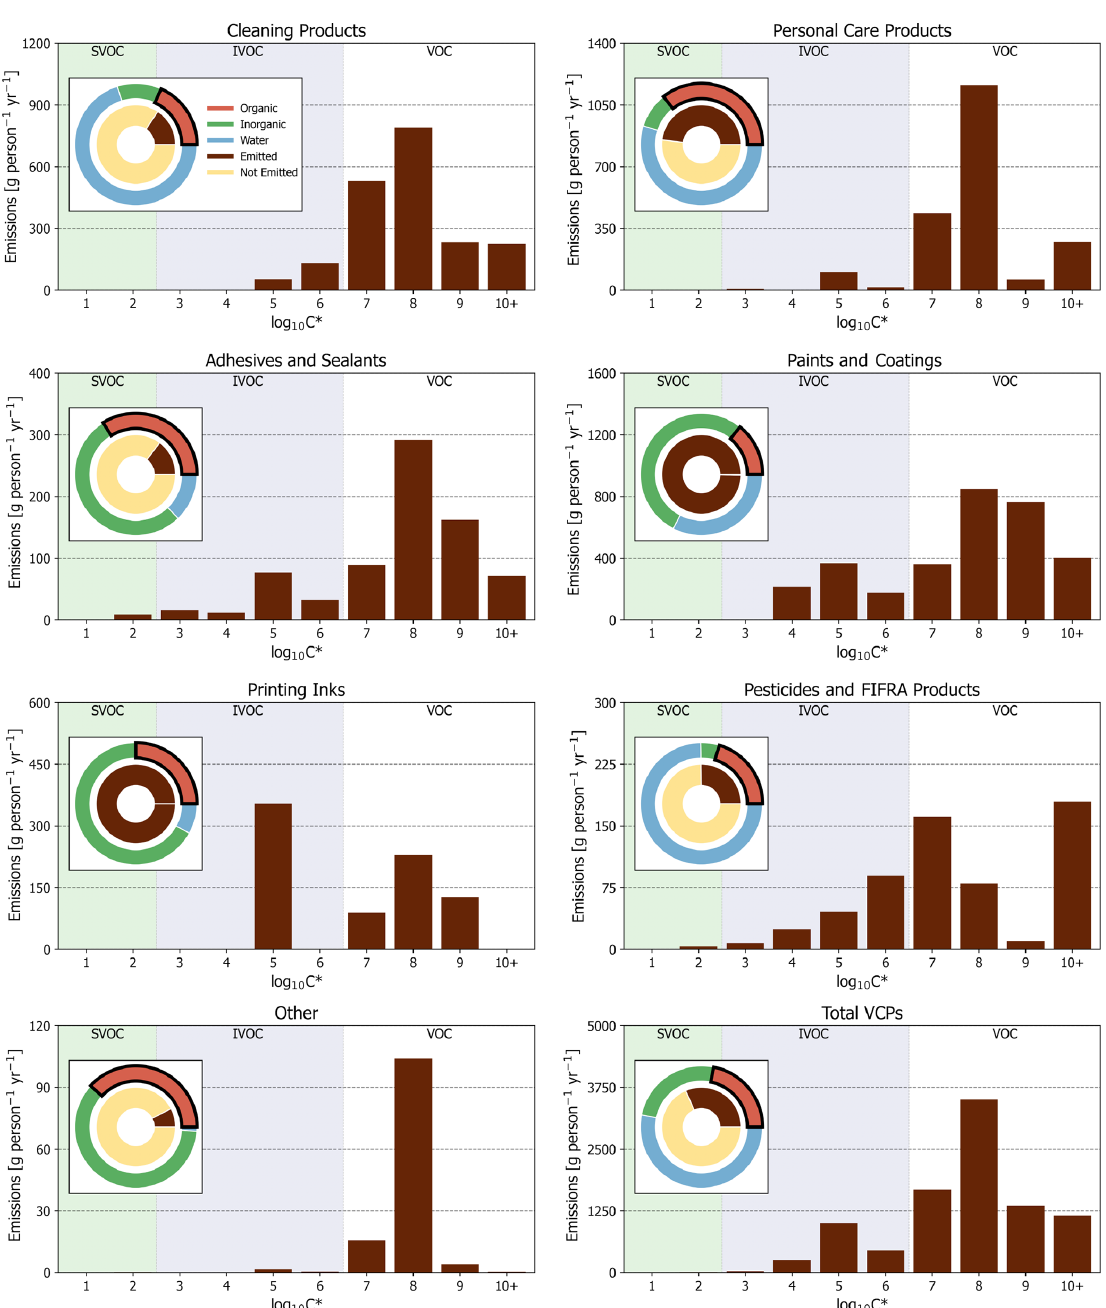
Figure 3. PUC and sector-wide volatility distribution of organic emissions. Other is a summation of dry cleaning, oil and gas, misc. products, and fuels and lighter. Pie charts are first-order product composition and organic emission proportions for PUCs and the complete sector. Note that the “organic” portion of all paints and coatings and printing inks pie charts is entirely composed of “evaporative organics” (see Table